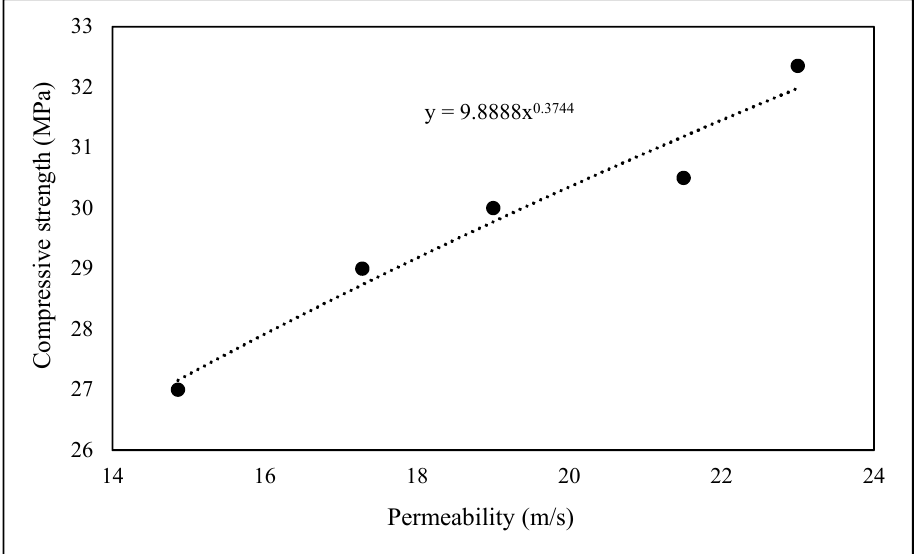
Figure 11. Regression relationship between the permeability and the compressive strength of concrete with wheat straw ash, and a mathematical equation.